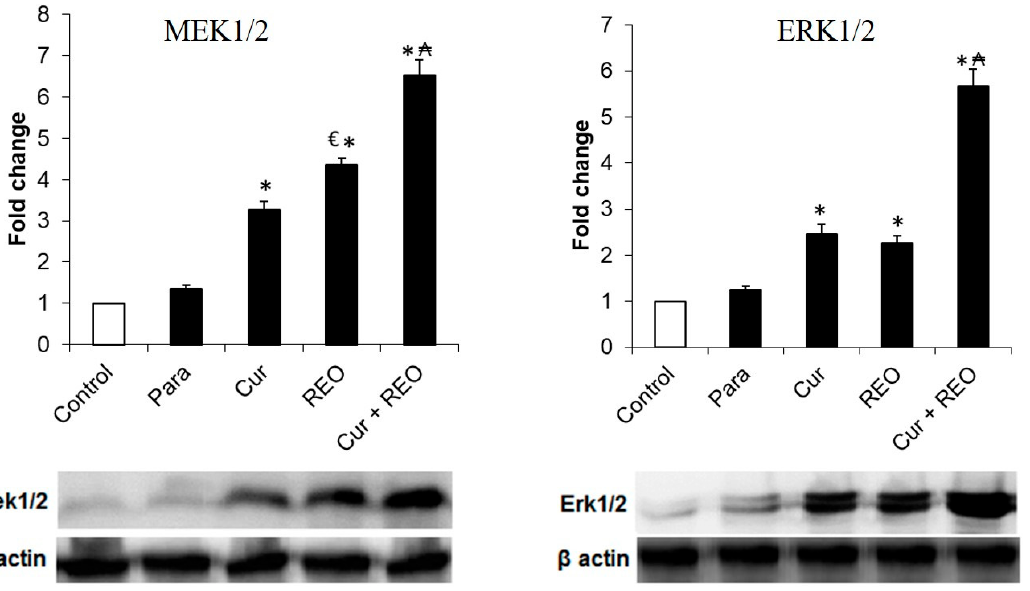
Figure 7. The effect of pretreatment with curcumin (Cur) and rosemary essential oil (REO) on expression of MEK1 and ERK1 proteins in liver homogenate on hepatic homogenate in paracetamol (Para) induced liver toxicity in mice. Each column represents the mean ± SD. The symbol designates statistically significant compared to the control group, * defines statistically significant compared to the Para group ( p < 0.05), € describes statistically significant compared to the REO group ( p < 0.05) and ₳ designates statistically significant compared to the Cur and REO groups ( p < 0.05) using one- way ANOVA followed by Tukey’s post hoc test.